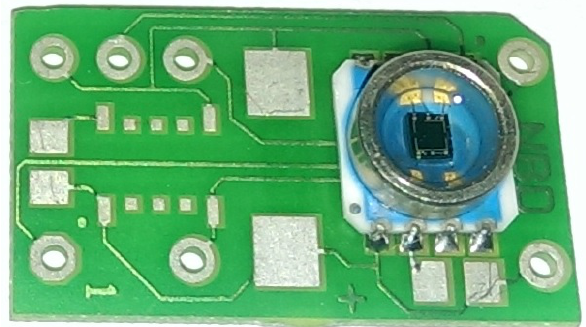
Figure 3. Miniature SMD (surface-mounted device) pressure sen- sor mounted on a read-out PCB (printed circuit board) developed by Intersema Sensoric (now Measurement Specialties, Inc., a TE Con- nectivity company; photo taken with permission from Measurement Specialties).